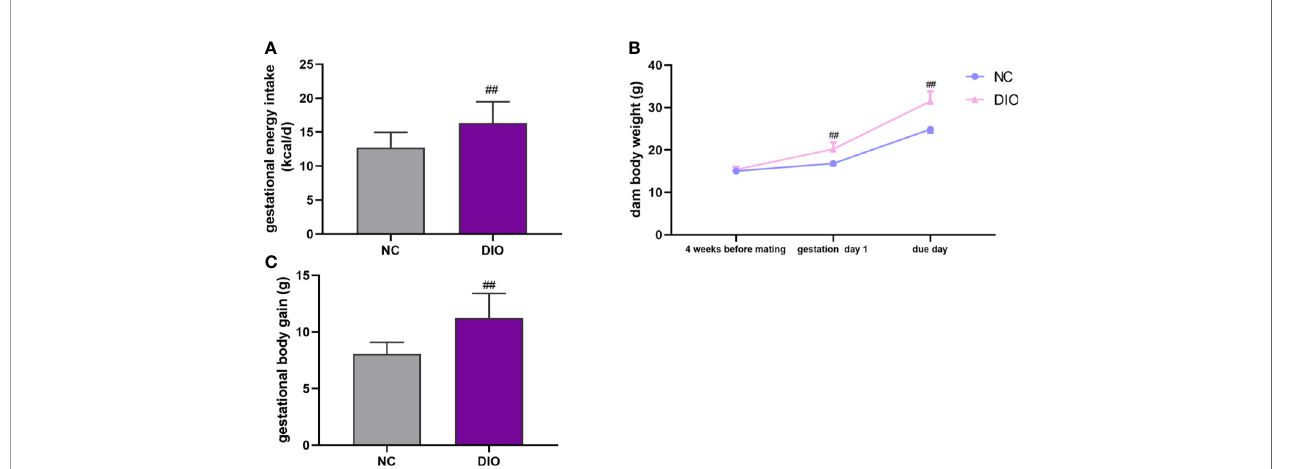
FIGURE 2 | Maternal characteristics. Maternal (A) energy intake during pregnancy, (B) body weight and (C) body weight gain during pregnancy. Values represent the mean ± SEM, n = 16 each group. ## P < 0.01 DIO vs . NC group. NC, normal control; DIO, diet-induced